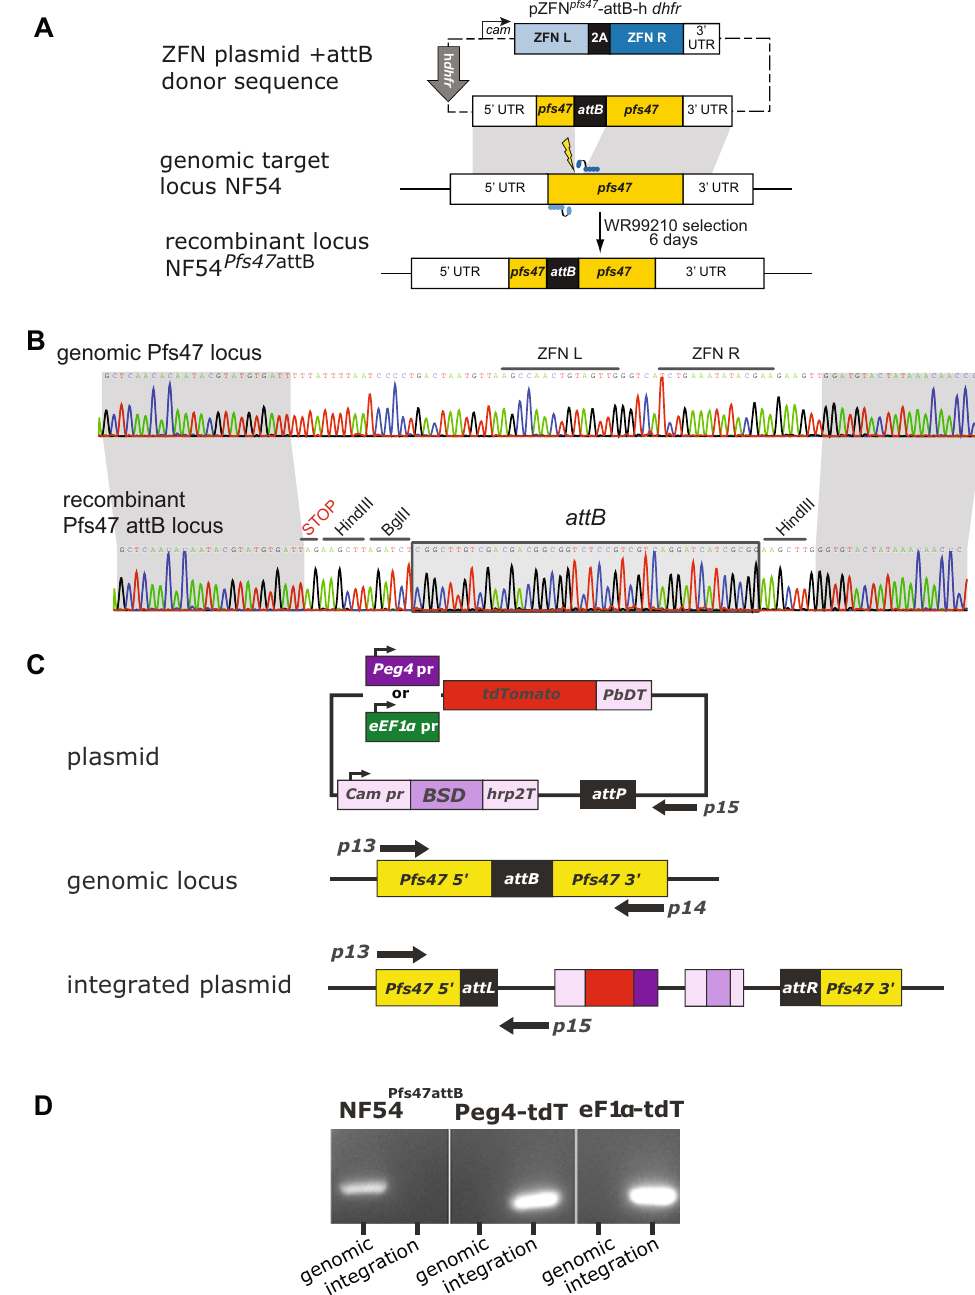
Figure 1. Introduction of the attB site into pfs47 locus and integration of tdTomato transgenes. ( A ) Schematic of the attB integration strategy. The expression of the pfs47 -specific ZFN pair is under the control of the calmodulin promoter and the hsp86 3 ′ UTR. The homologous donor sequence provided for double-strand break repair comprises a fragment of pfs47 stretching 0.68 kb upstream and 0.87 kb downstream of the ZFN target site (thunderbolt). The attB site is located between the two homologous regions and replaces the genomic pfs47 sequence containing the ZFNs binding site upon integration. The transfection plasmid pZFN pfs47 -attB- hdhfr also contains a selectable marker for transient selection and propagation of the plasmid. ( B ) Sequence analysis of the unmodified endogenous pfs47 locus of the parental parasite line NF54 and the gene-edited recombinant locus NF54 pf47-attB . ( C ) Schematic of the tdTomato plasmids used for transfection ( PbDT = P . berghei DHFR-TS terminator, Cam pr = calmodulin promoter, BSD = Blasticidin S Deaminase selectable marker, hrp2T = HRP2 terminator) and of the NF54 Pfs47attB attB locus pre- and post-integration of the tdTomato plasmids. Position of primers used to amplify the genomic locus (p13 & p14) and the integrated plasmid (p13 & p15) are shown. ( D ) PCR verification of plasmid integration. Primers p13 and p14 generate a 334 bp product from the unmodified pfs47attB locus (genomic), and primers p13 and p15 generate at 287 bp product upon tdTomato plasmid integration (integration). Shown is one gel with lines between lanes added to delineate the different Plasmodium clones. Primer sequences in Table